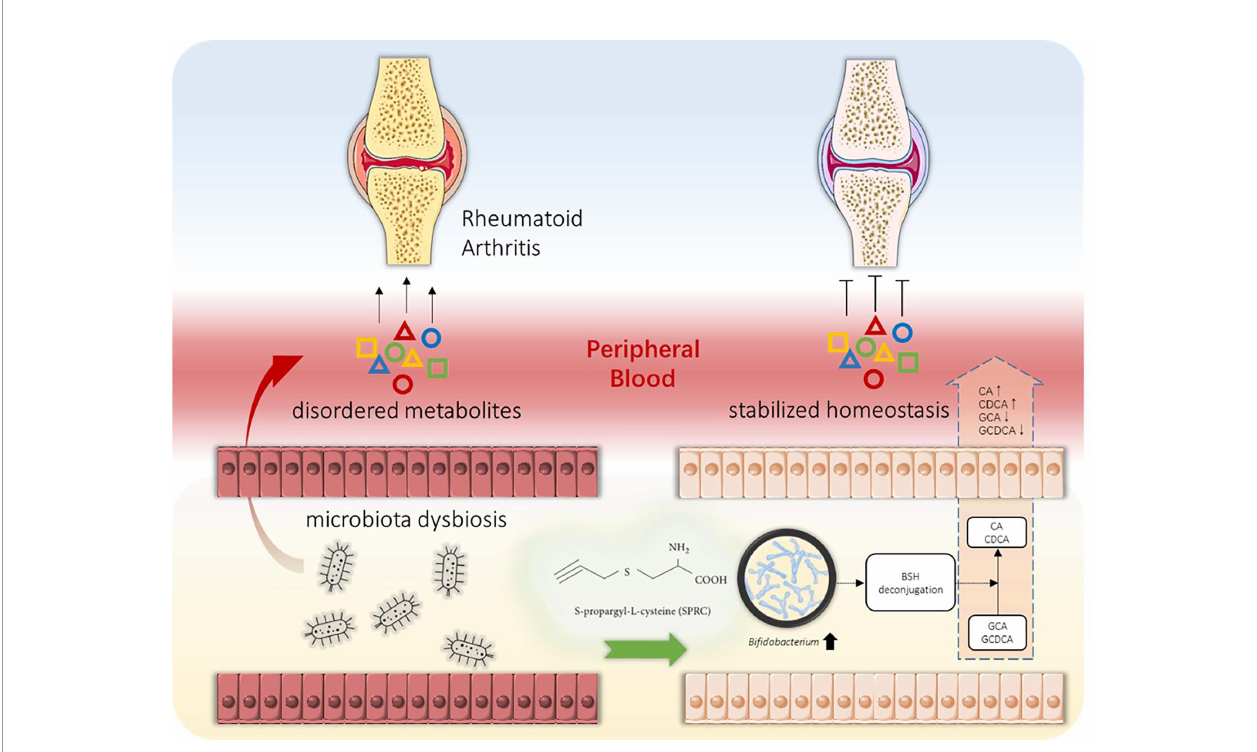
FIGURE 10 | Schematic diagram of the gut-joint axis in RA progression and the intervention strategy. Along with joint in fl ammatory symptoms, the alteration in the gut microbiota during RA progression might cause metabolic disorders. Abnormal metabolite production provokes peripheral in fl ammation and enhances the in fl ammatory response in joint tissue, resulting in pathological synovial tissue in fl ammation and cartilage impairment (left panel). Oral administration of SPRC remodels the gut microbiota, increases the levels of speci fi c probiotics, reduces peripheral in fl ammation, and decreases GCA and GCDCA levels, leading to the reversal of RA progression (right